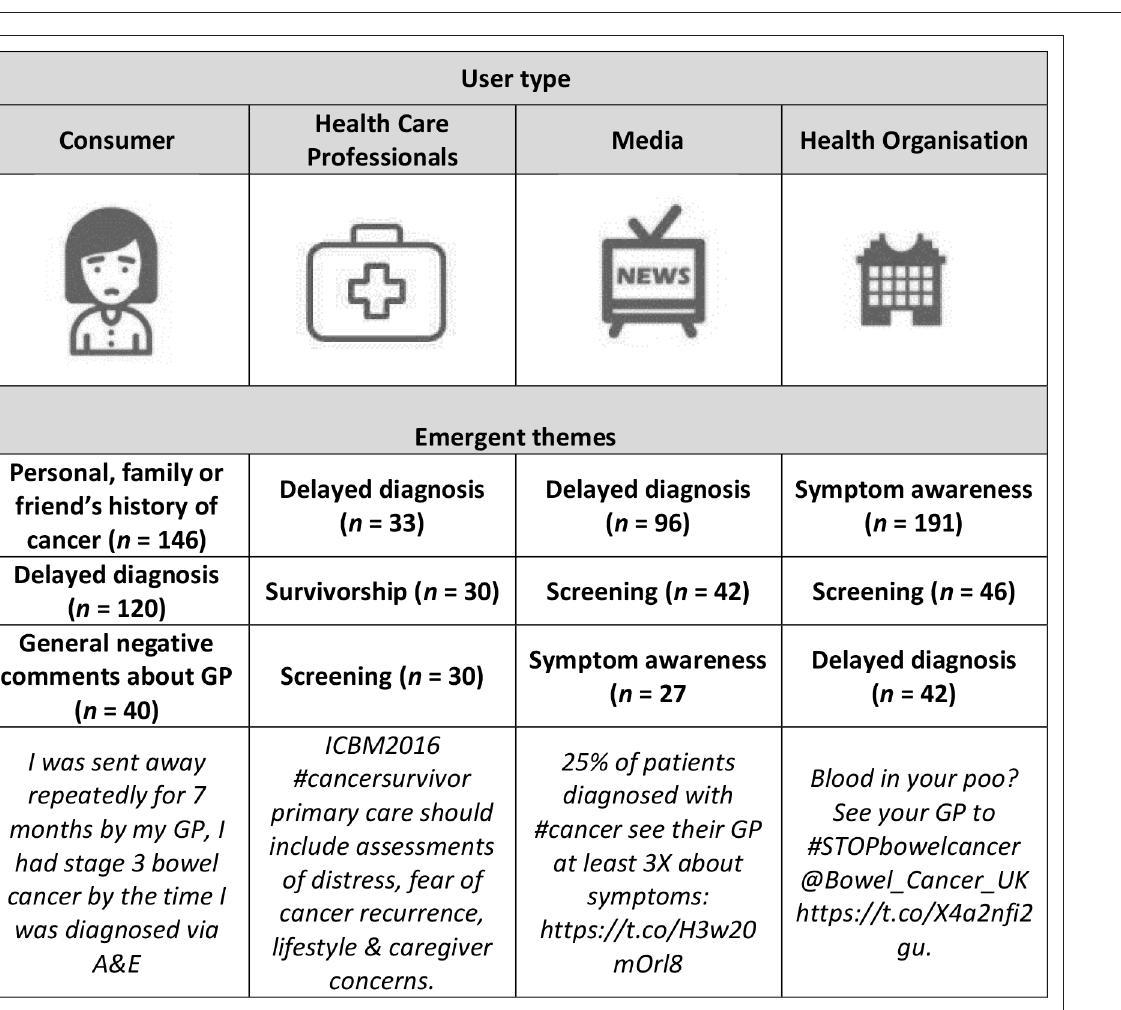
Milley KM et al . BJGP Open 2021; DOI: 10.3399/bjgpopen20X101134